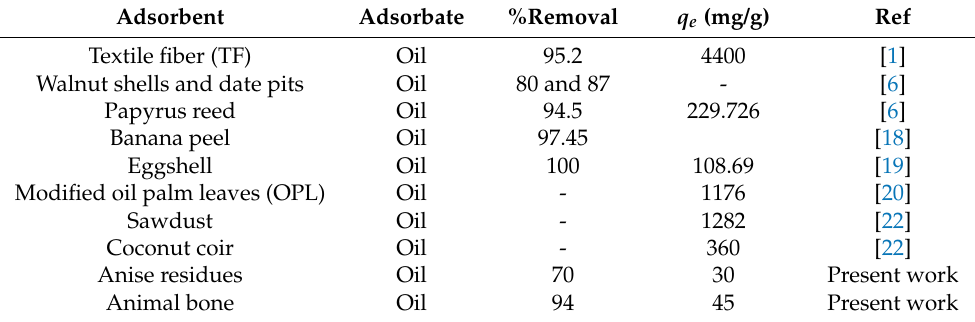
Table 3. Synthesised and natural adsorbents for oily water